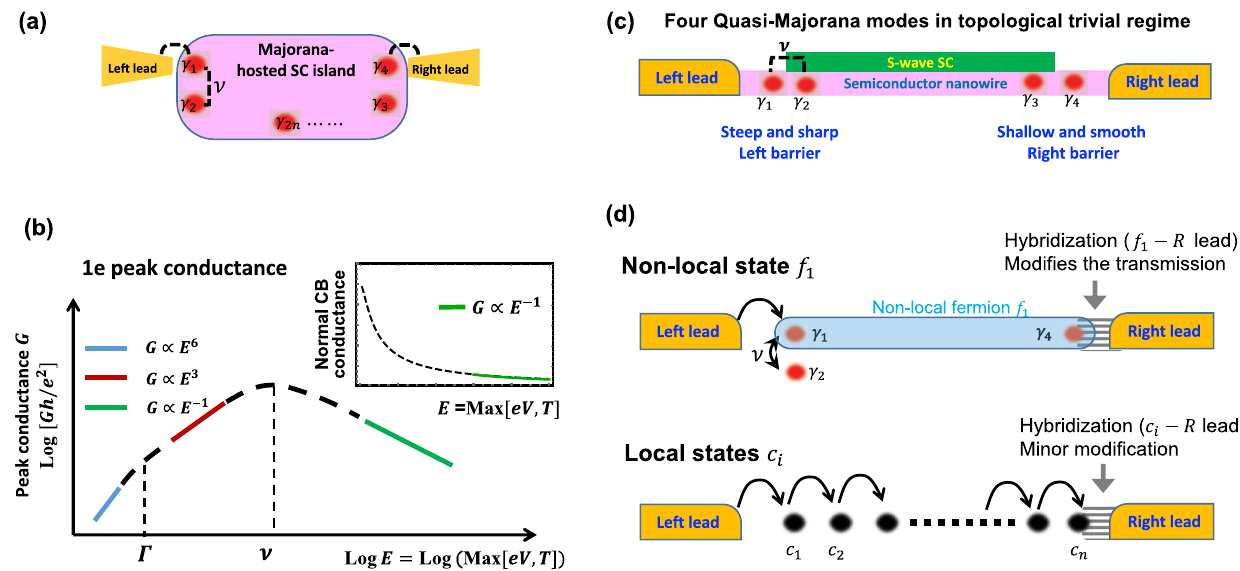
Fig. 1 | Possible system setups and our major predictions. a Illustration of our systemthatconsistsoffourormoreMZMsonoppositesidesofthenanowire.Two of them ( γ 1 and γ 2 ) are coupled with the strength ν , and only γ 1 and γ 4 ) are con- nected to leads. b The CB peak conductance through our Majorana-hosted island that is tuned to the half- fi lling. For more intuitiveness, we use logarithmic coordi- nates and fi nd that it is non-monotonic in temperature. Inset: the monotonic temperature-dependence peak conductance of normal CB peaks. c Illustration of another possible realization of our system. d A picture on what happens after the